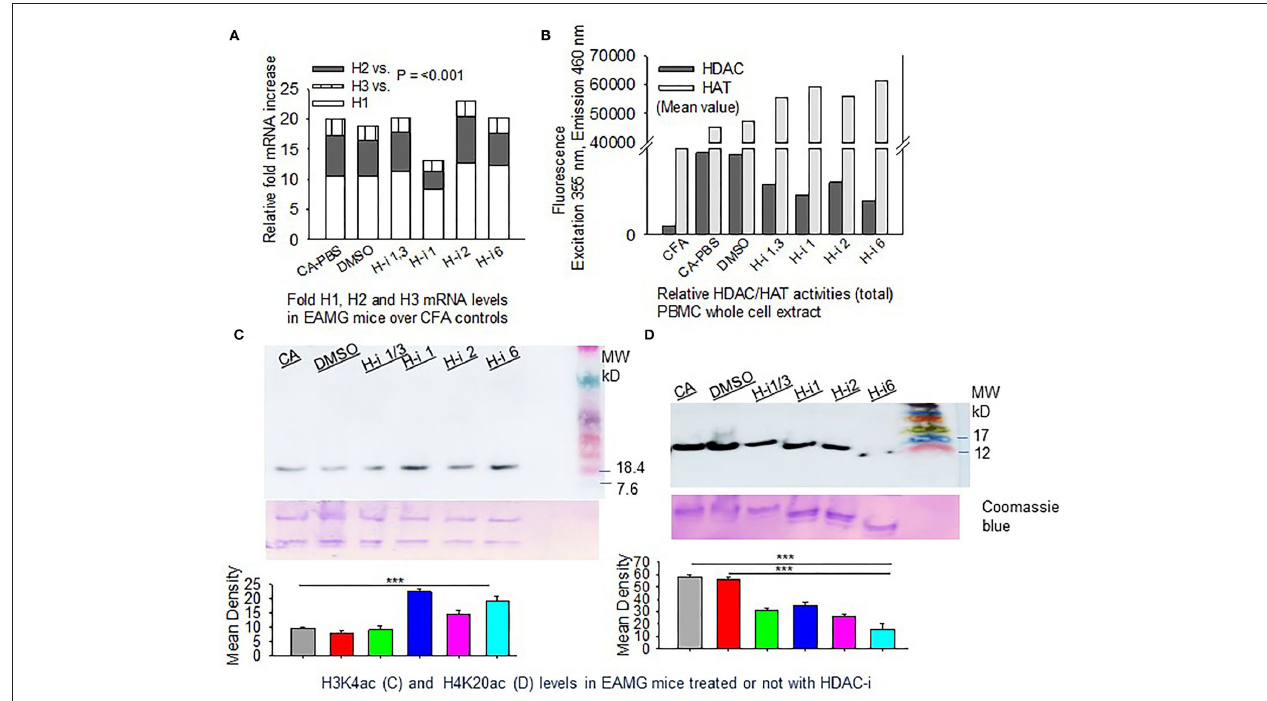
FIGURE 3 | HDAC expression and HDAC vs. HAT activities in PBMCs. CFA and EAMG mice ( ± HDAC-i) were bled 72h post 2nd and 3rd treatments. (A) Relative mRNA fold changes of HDAC isoforms 1, 2, and 3 in AChR-stimulated PBMCs from post 3rd treatment. (B) Relative HDAC/HAT total enzymatic activities in the whole-cell extract of AChR-stimulated PBMCs from post 2nd treatment. Data (fluorescence intensity) shown are the mean values of the pooled samples in wells assayed in duplicate ( n = 3 for CFA; n = 5 for CA-PBS and each treatment groups). (C,D) Immunoblots showing H3K4ac and H4K20ac in whole-cell lysates of splenocytes from EAMG mice treated or not with HDAC-i. Bottom panel: nonspecific bands to show loading uniformity in the gel stained with Coomassie blue. The experiment was repeated thrice. *** P < 0.001, ANOVA.